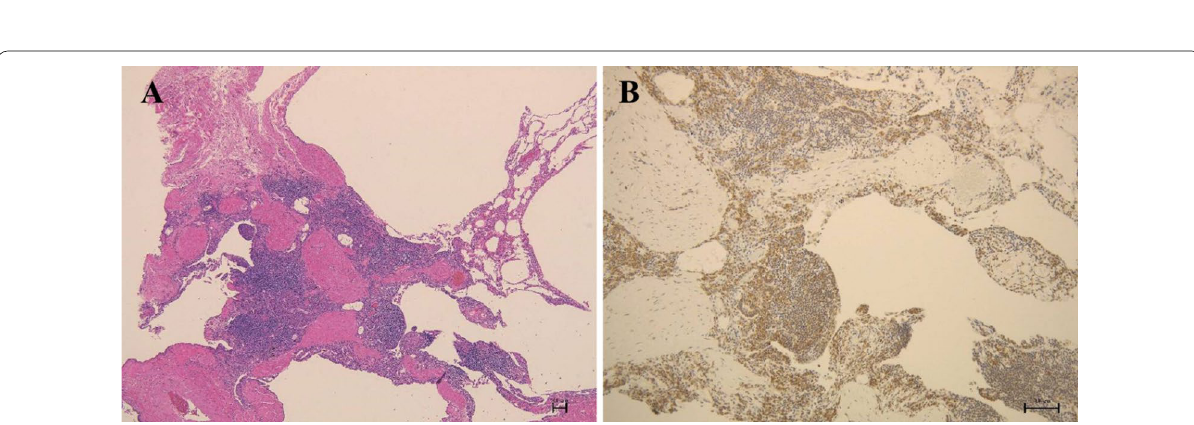
Fig. 2 Pathology of the explanted native right lung. A Lower lobe shows a cystic enlargement of the alveolar walls and interstitial infiltration of lymphocytes and plasma cells (hematoxylin and eosin staining, original magnification: 40 interleukin-6 (IL-6)-positivity (Immunofluorescence staining of IL-6, original magnification: 100